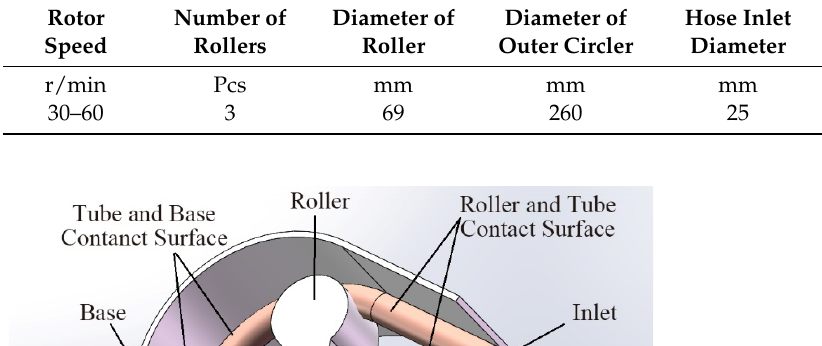
Table 1. Material parameters of the hose.